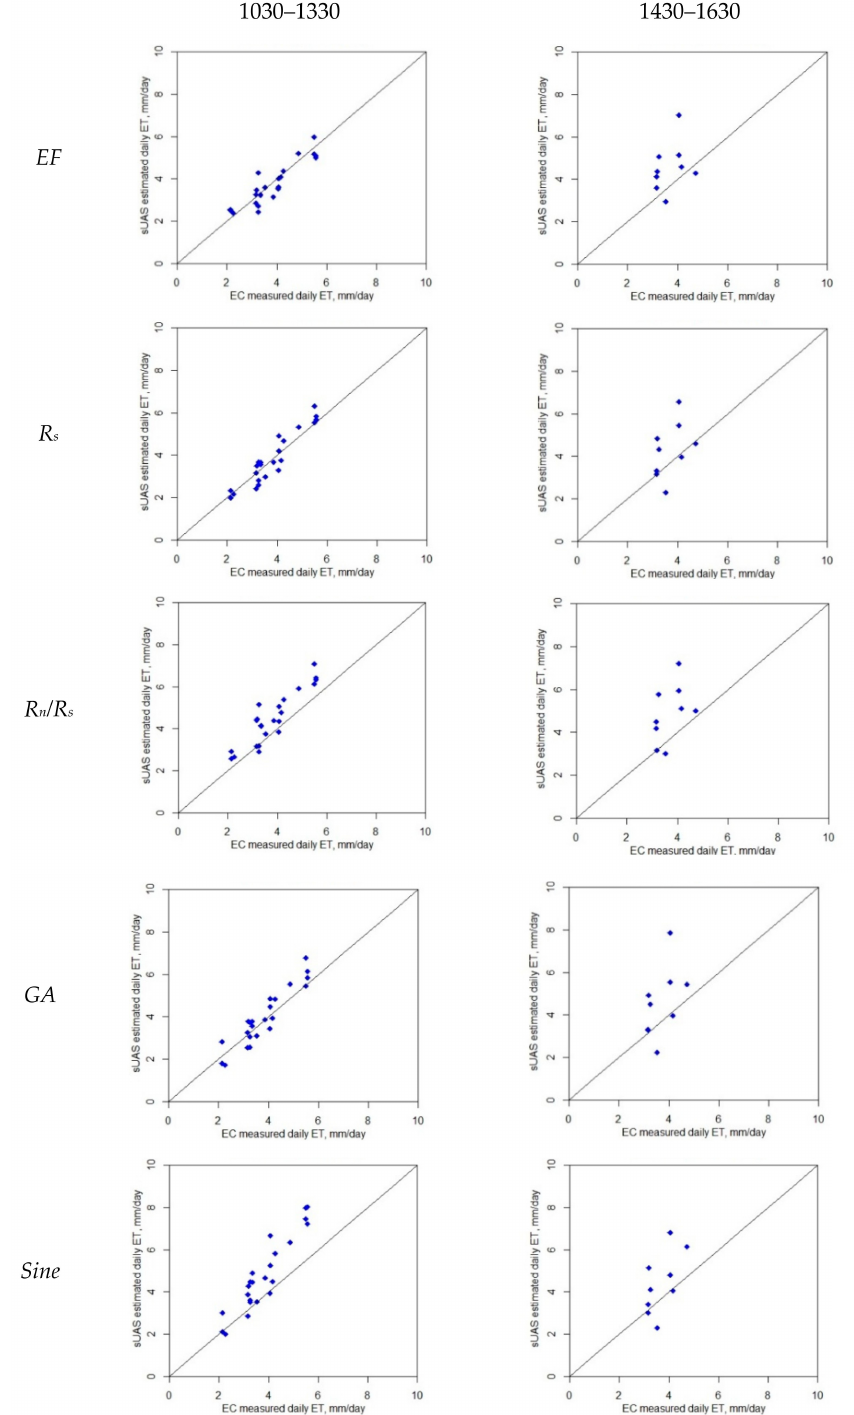
Figure 8. Comparison between daily ET from TSEB sUAS and EC at two different time windows (1030–1330 and